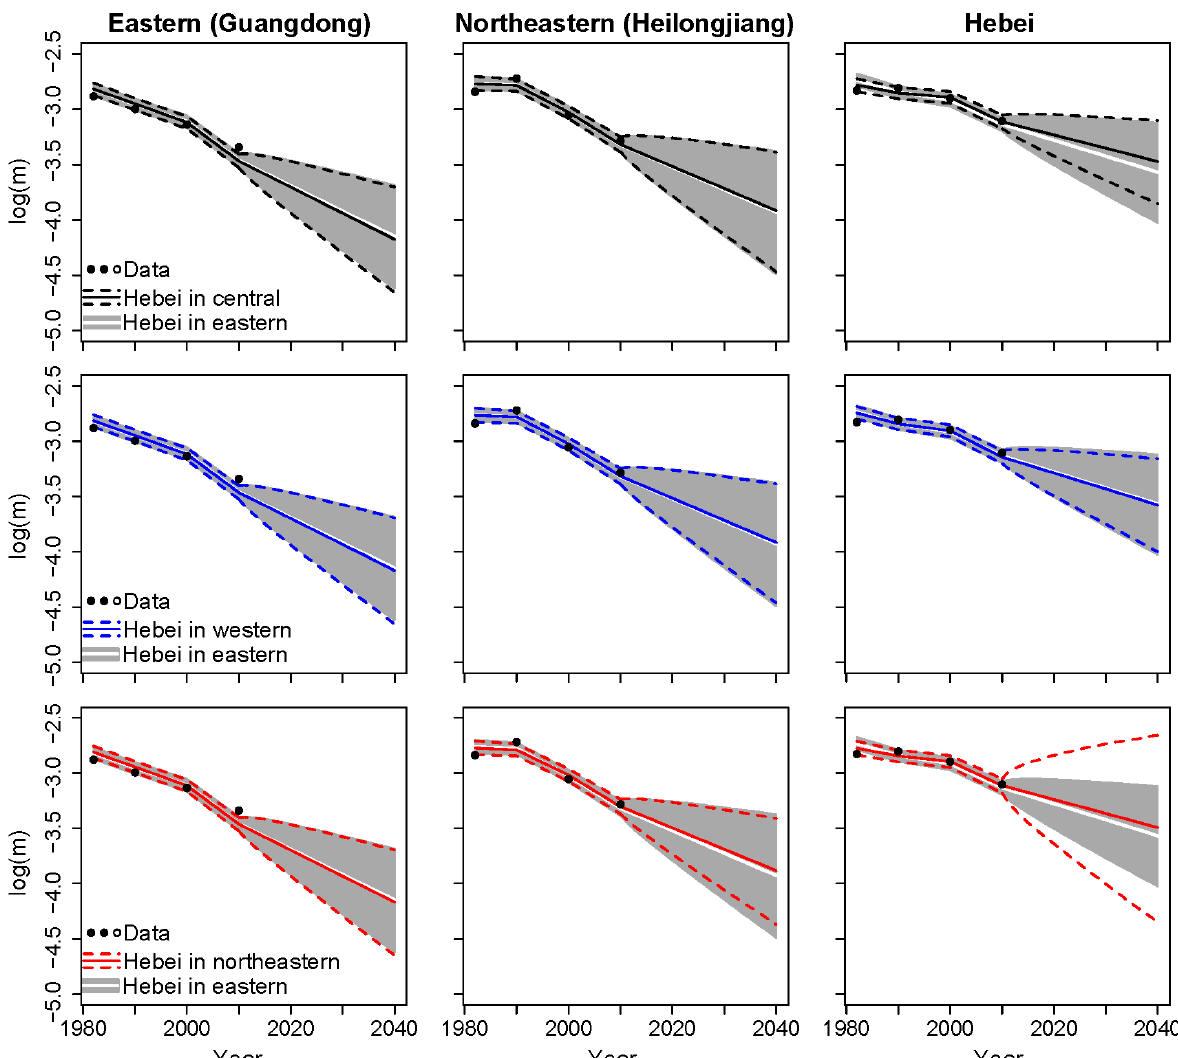
Figure 8. Results of different grouping assumptions in the proposed model (for ages 70–74).